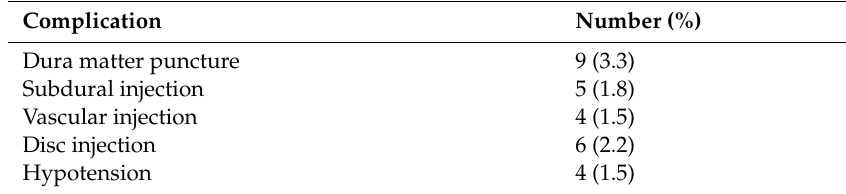
Table 5. Cumulative list and rate of the observed complications during the decompression and adhesiolysis with an inflatable balloon